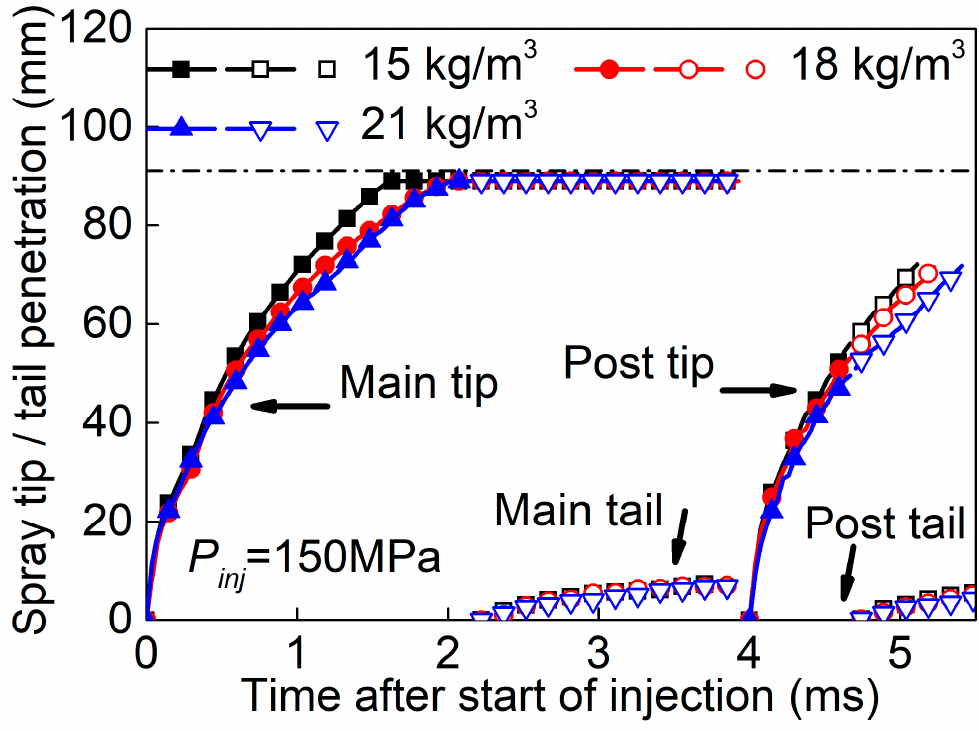
Figure 14. Results of tip and tail penetrations when applying the main-post injection strategy under various surrounding gas